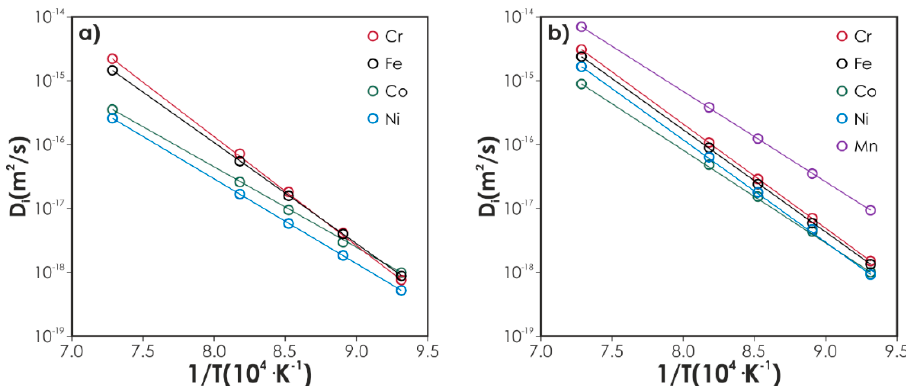
Figure 18. Temperature dependence of tracer bulk diffusion of all constituents in ( a ) CoCrFeNi, ( b ) CoCrFeMnNi (after [39]). Reprinted from Acta Materialia 146 (2018), Bulk tracer diffusion in CoCrFeNi and CoCrFeMnNi high entropy alloys, 211–224, Copyright 2018, with permission from Elsevier.